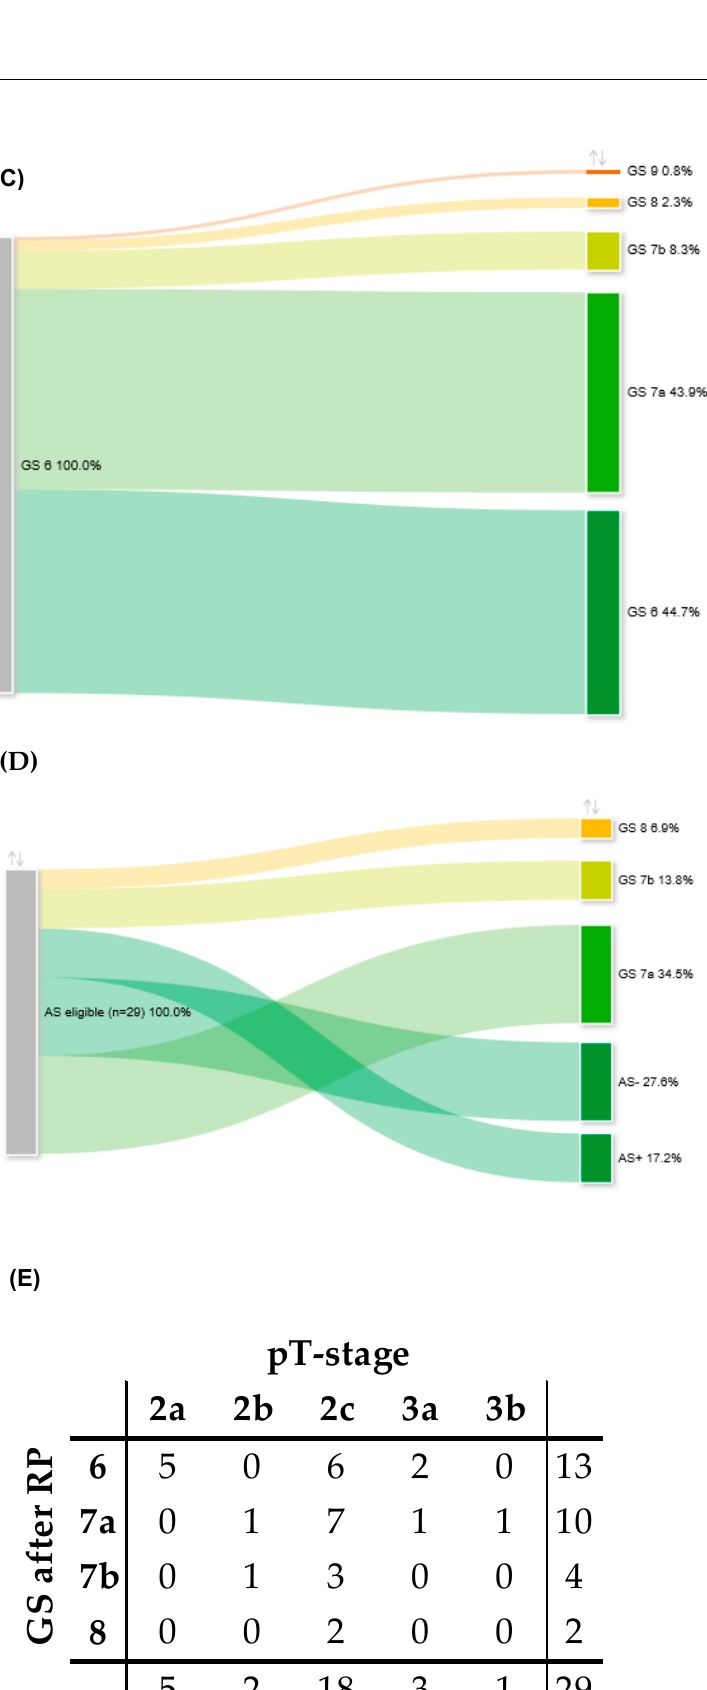
Figure 2. ( A ) Sankey diagram of change in GS comparing FBx specimen (left column) and RP specimen (right column). ( B ) Concordant, up- and downgrading rates of different GS after FBx and consecutive RP as depicted in Figure 2A. ( C ) Sankey diagram of adverse pathology of GS 6 PCa after FBx (left column) and consecutive RP (right column). ( D ) Sankey diagram of upgrading and ‐ staging of patients assessed as eligible for AS after FBx (left column) and consecutive RP (right column). ( E )